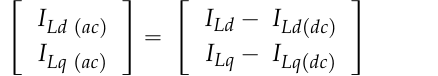
Figure 2. Harmonics extraction based on SRF algorithm.